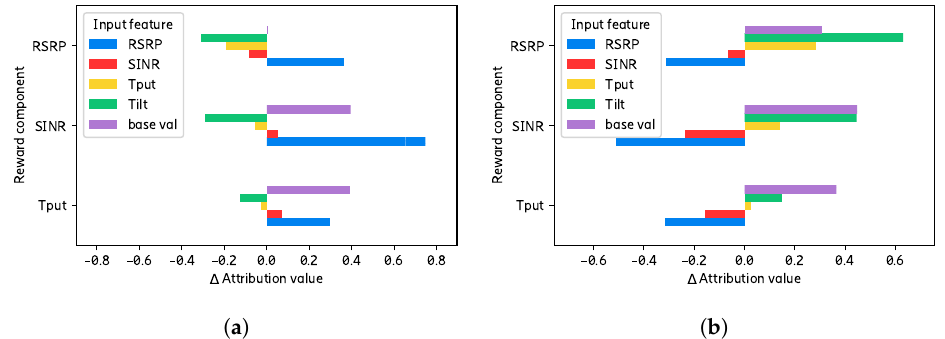
Figure 10. Contrastive explanations generated using BEERL where the MSX is highlighted. ( a ) Contrastive explanations about why no tilt action is chosen rather than tilting down. ( b ) Contrastive explanations about why no tilt action is chosen rather than tilting